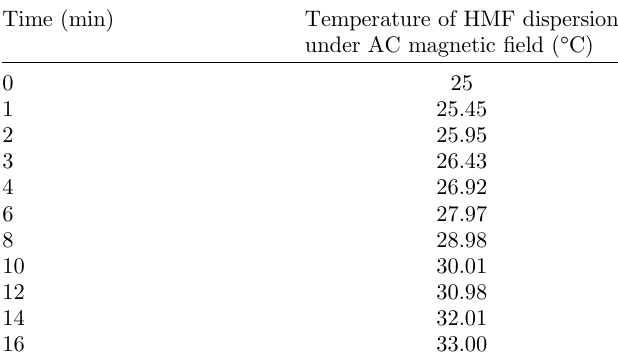
Table 1. Temperature gain by HMF under AC magnetic fi eld. Time (min) Temperature of HMF dispersion under AC magnetic fi eld ( (cid:1)